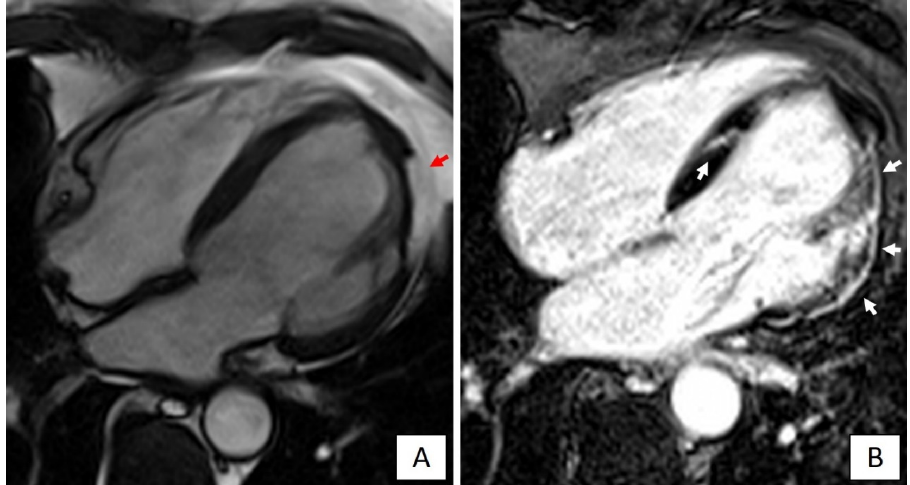
Figure 3. Electrocardiogram of patient with desmoplakin ( DSP )-related left dominant arrhythmogenic cardiomyopathy. Basal electrocardiogram showing T-wave inversion in lateral leads and low QRS voltages (<0.5 mV) in limb leads.